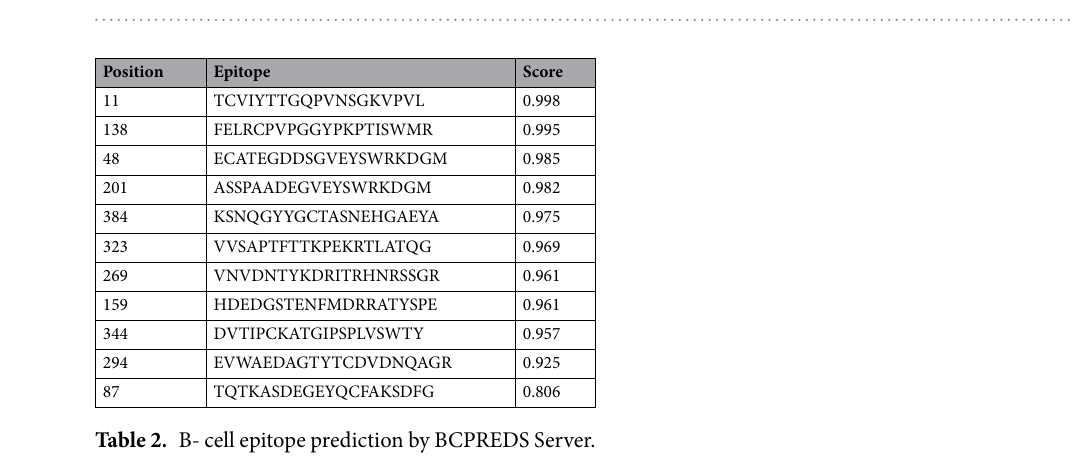
Table 1. HTL epitope prediction by IEDB Server.